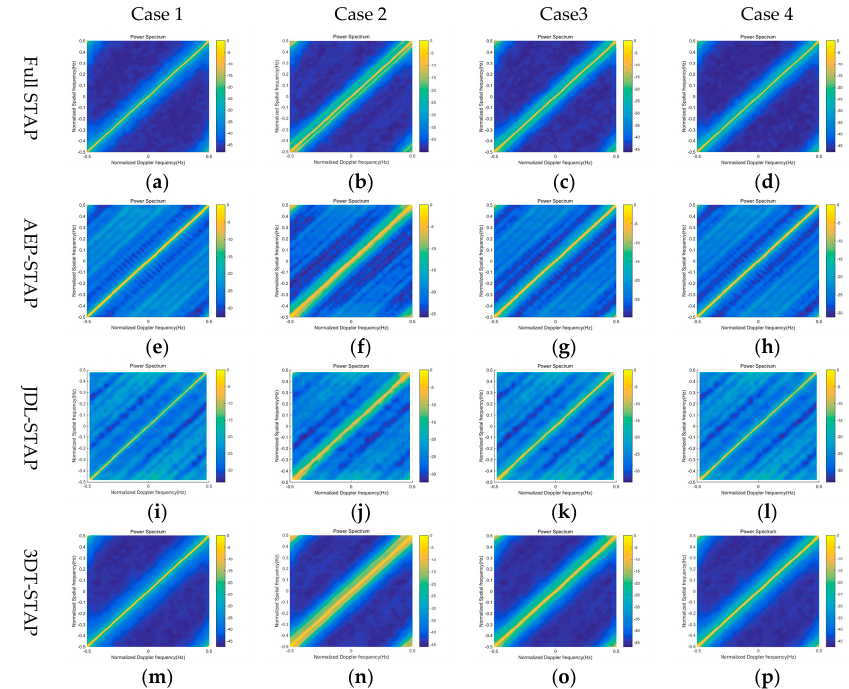
Figure 3. Spatial-temporal clutter spectrum in different cases: ( a ) Full STAP in case 1; ( b ) full STAP in